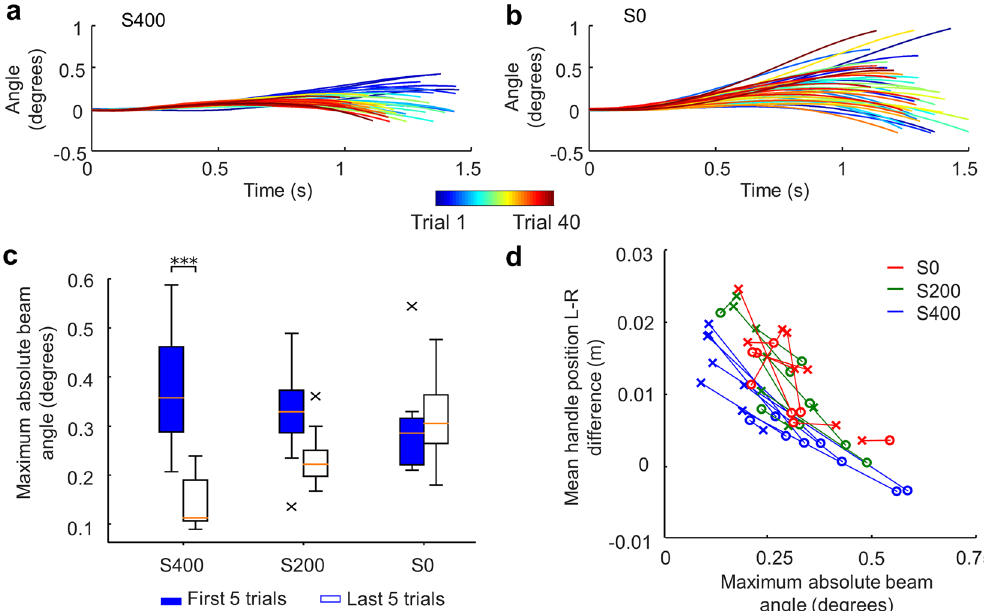
Figure 5. Changes of maximum beam angle across successful trials . ( a ) and ( b ) show maximum beam angle from individual successful trials performed by one dyad in the S400 condition and one dyad in the S0 condition, respectively. Early trials are plotted as blue traces, and subsequent trials are denoted by ’warmer’ colors. Data shown in panels ( a ) and ( b ) are from 40 trials. ( c ) Comparison between first and last five successful trials within each experimental condition (*** denotes p < 0.001). The ‘×’ symbols in the whisker plot denote outliers. Vertical bars denote 1.5 interquartile range. Data are from 48 subjects (24 dyads; 8 dyads per experimental condition). ( d ) Relationship between maximum absolute beam angle and mean hand position difference. Each data point is from one dyad and experimental condition. Each data point denotes the average of the first and last five successful trials (circles and crosses, respectively) from all dyads. Blue, green, and red symbols denote data from S400, S200, and S0 conditions, respectively. Symbols connected by lines are from the same